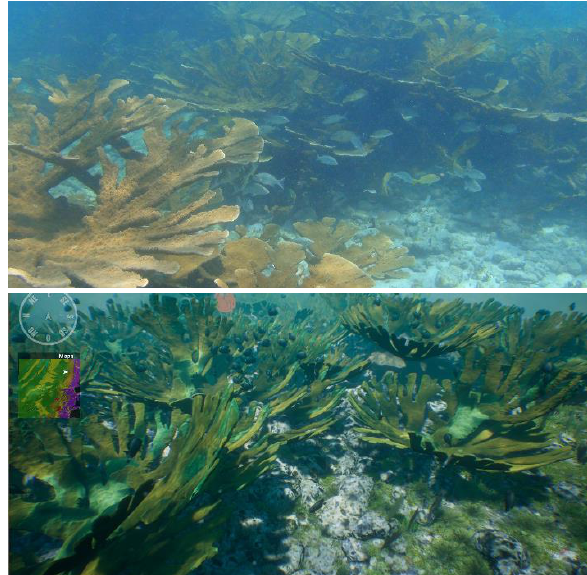
Figure 1. Ratio of 1:1 between physical reality (above) and virtual reality (below). Example from a GeoIVE of a